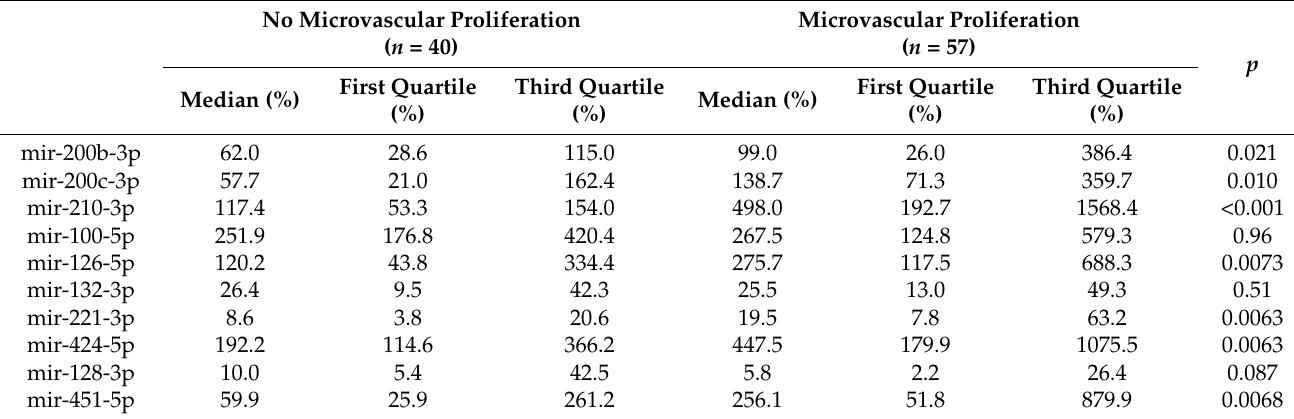
Table 3. MiRNA expression according to microvascular proliferation.